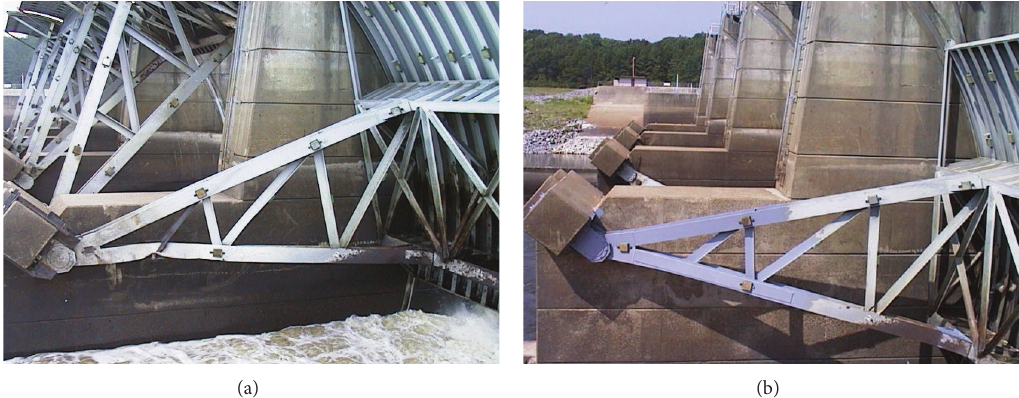
Figure 5: Tainter gate with strut arm damage from barge impact before and after repairs.